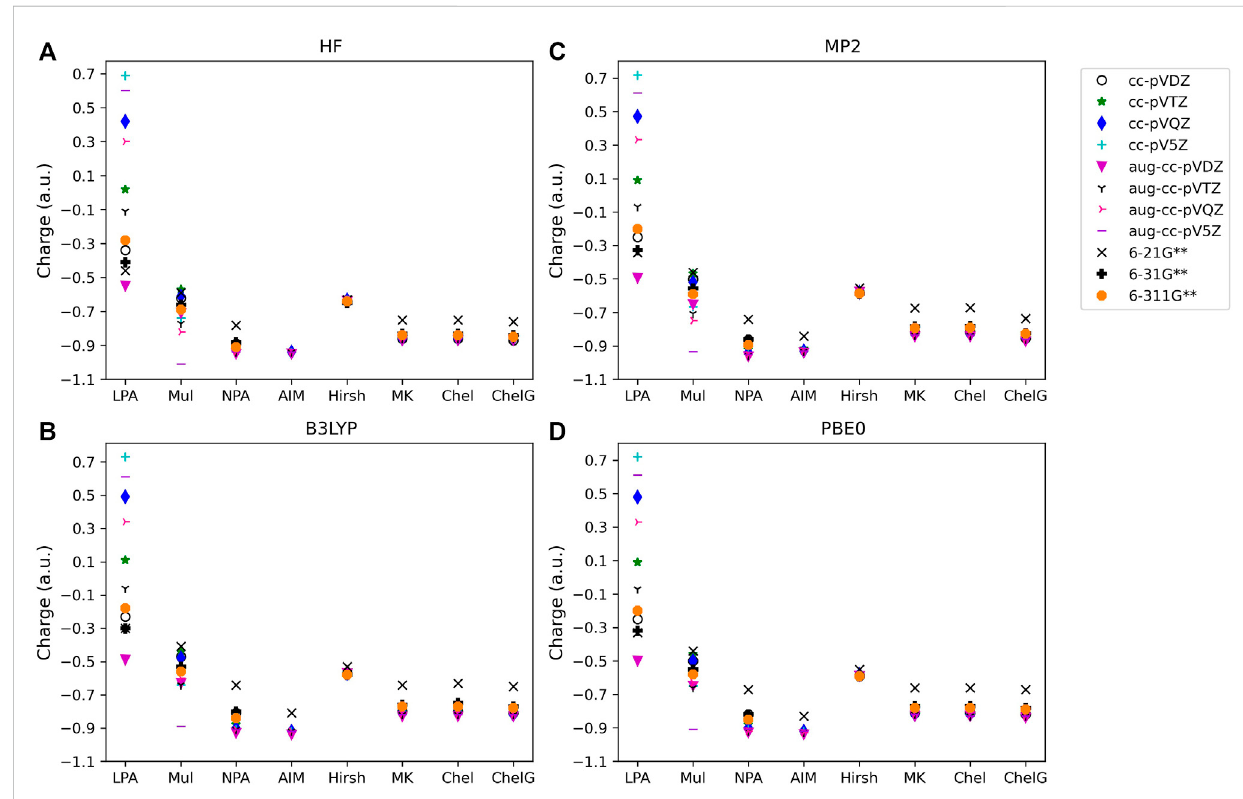
FIGURE 1 Atomic charge determined for noted basis set, analysis method,and quantum mechanical method: (A) HF, (B) B3LYP, (C) MP2, and (D) PBE0for one of the diatomic compounds investigated, LiF. Charges for the remaining three diatomic molecules studied are included in the SI.